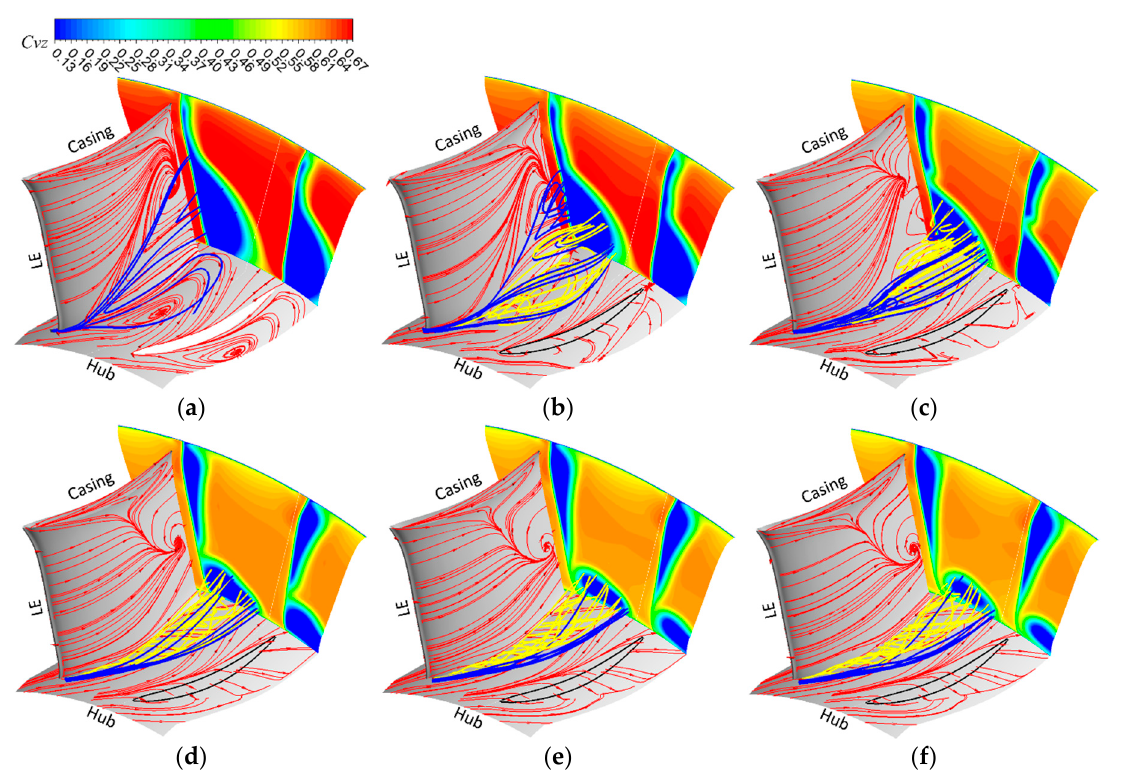
Figure 10. Three-dimensional flow structures inside the stator passage in the NS condition. ( a ) 0.00 τ , ( b ) 0.25 τ , ( c ) 0.50 τ , ( d ) 1.00 τ , ( e ) 1.50 τ , ( f ) 2.00 τ .